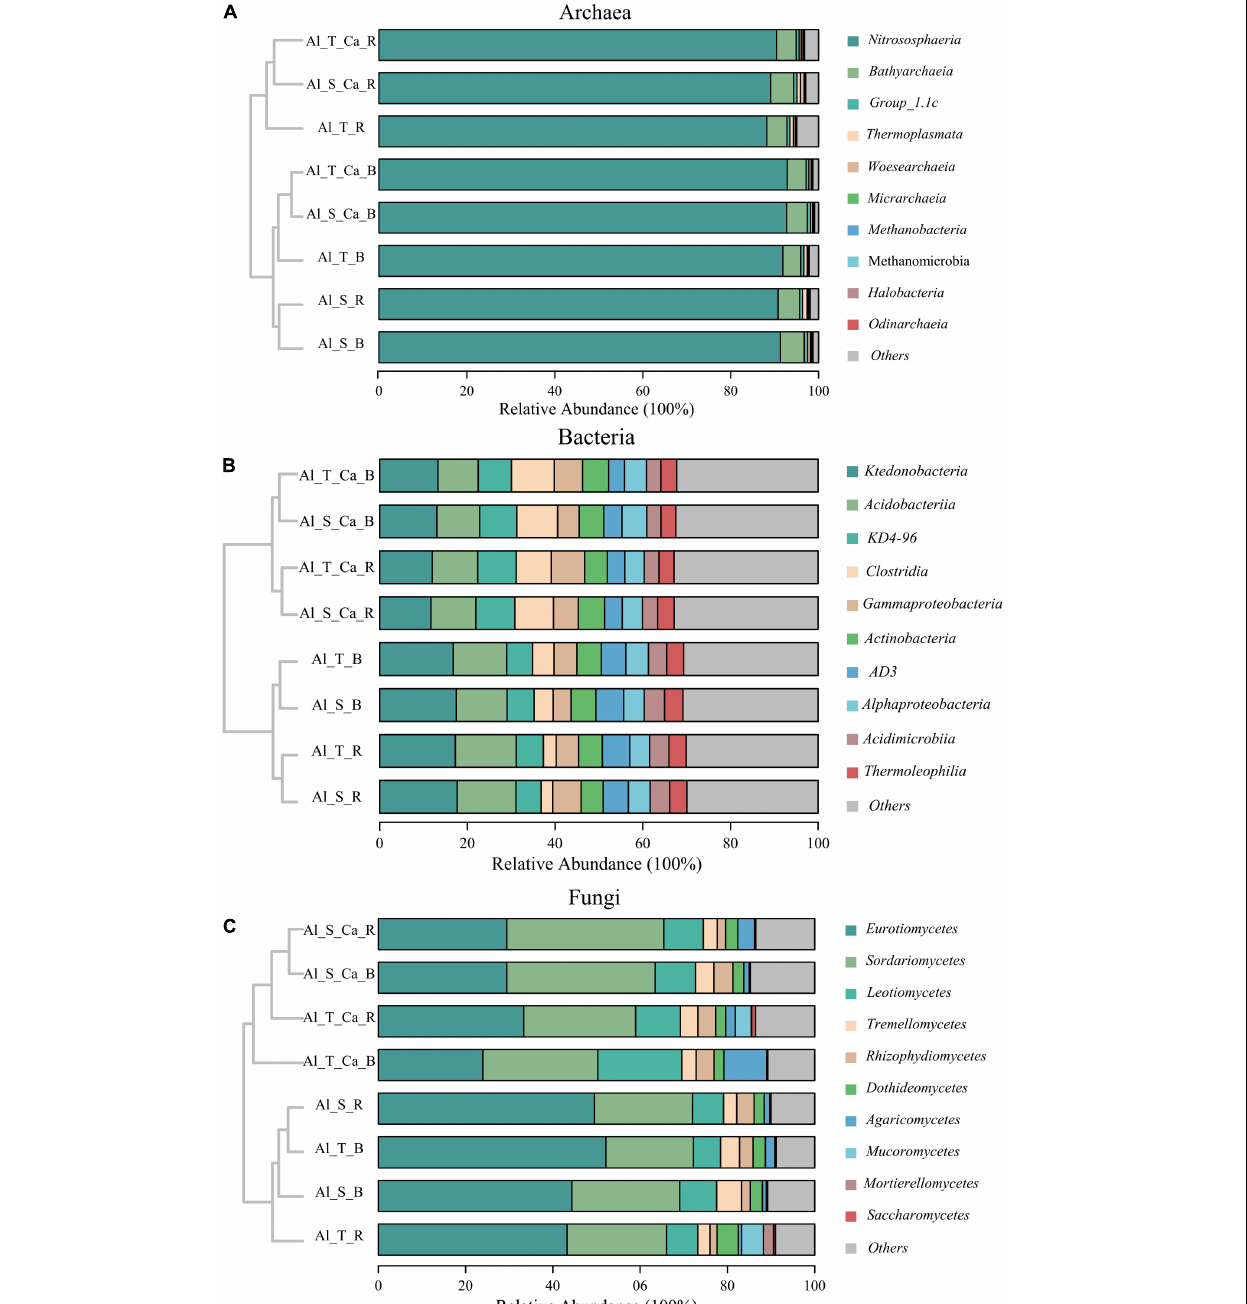
explained the largest proportion of this variation, but other soil factors, including Mg, Mn, and Al in the bulk soil as well as contributed to the variation in the rice biomass ( Figure 6A